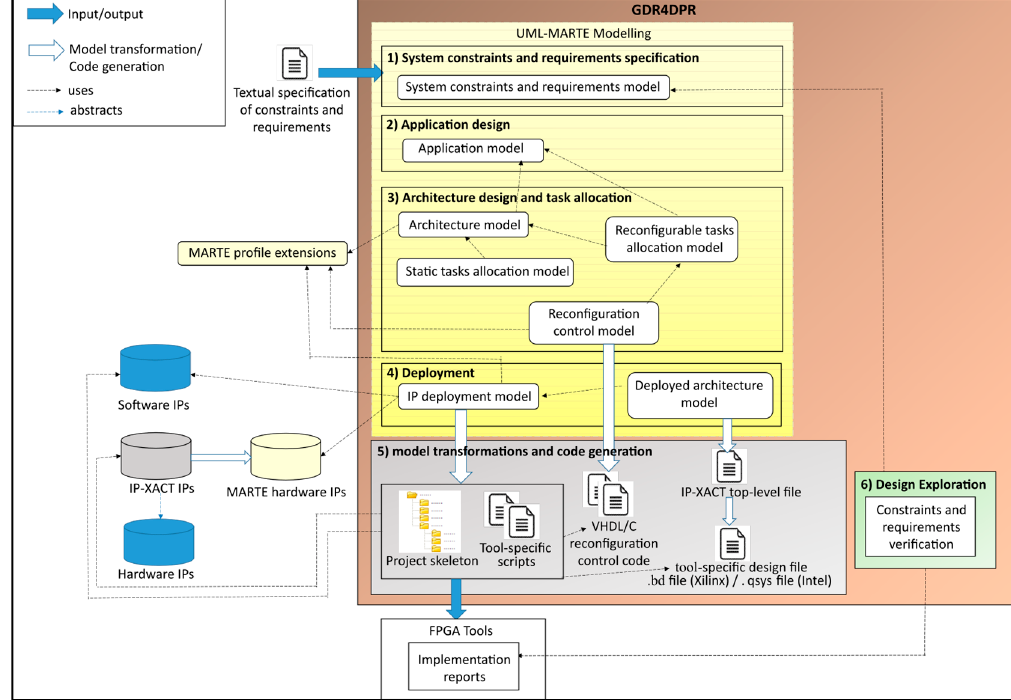
Figure 1. The proposed GDF4DPR design flow.